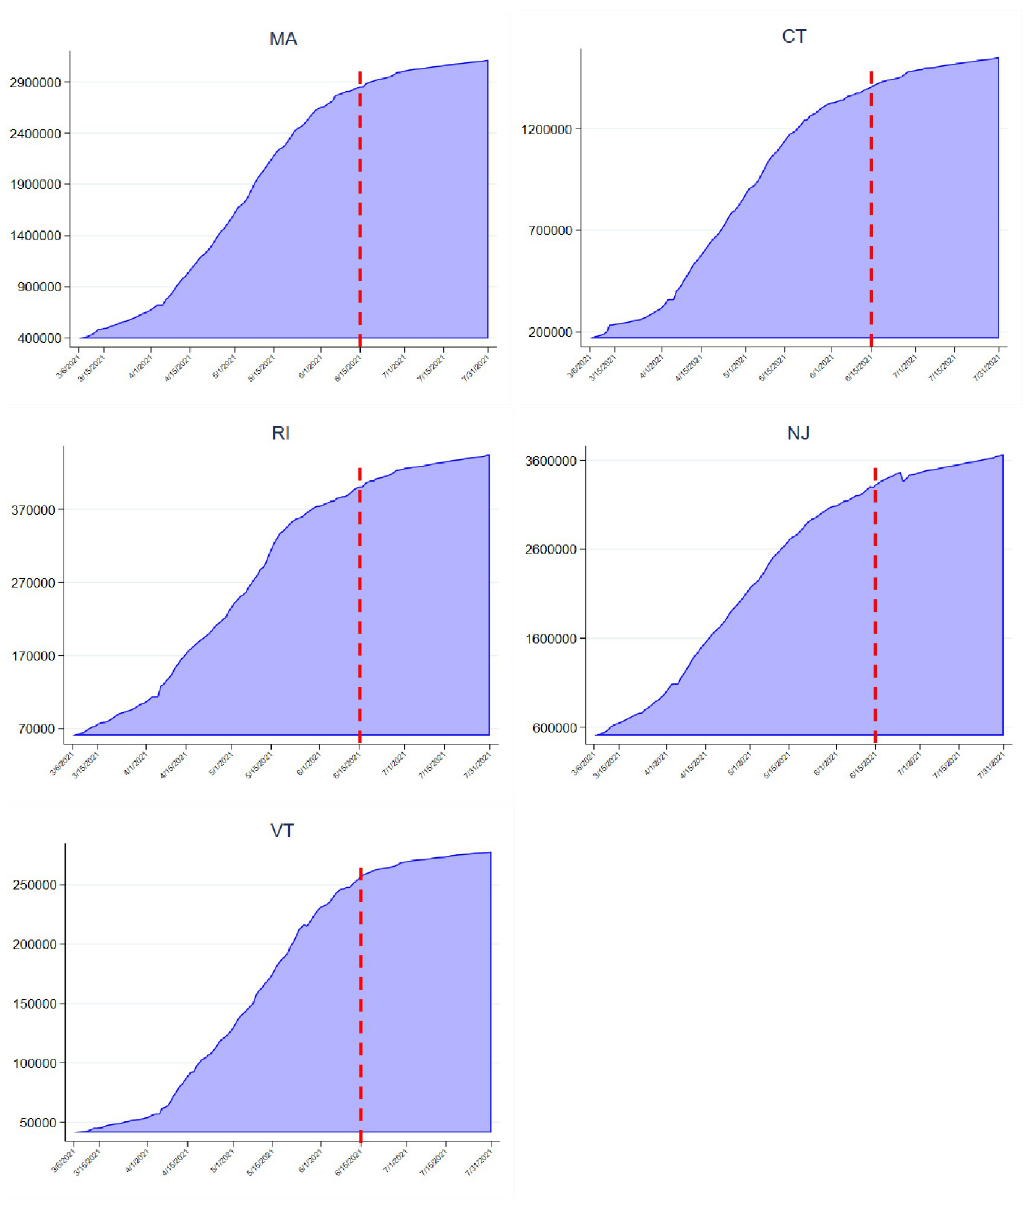
Fig 1. Cumulative number of fully vaccinated adults aged 18 to 64 in Massachusetts and other four comparison states. Abbreviations: MA, Massachusetts; CT, Connecticut; RI, Rhode Island; NJ, New Jersey; VT, Vermont. Note: Vertical dash line indicates Massachusetts COVID-19 Vaccine announcement date. Source: Author’s analysis of the Centers for Disease Control and Prevention COVID-19 Vaccine Tracker.